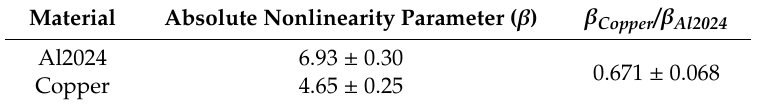
Table 3. Absolute acoustic nonlinearity parameters of Al2024 and copper measured by the direct method.